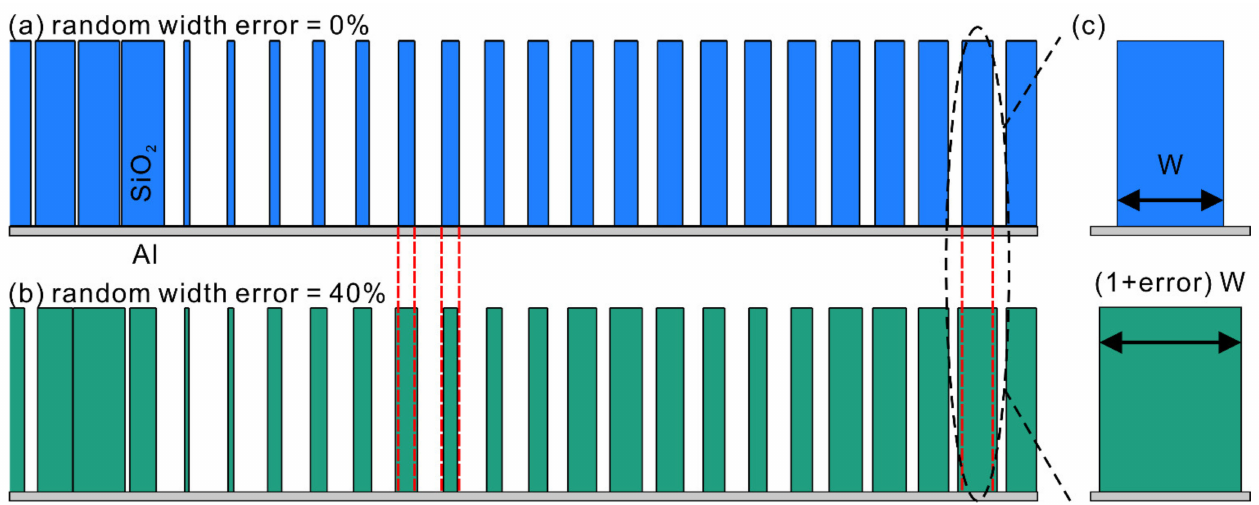
Figure A5. Schematic illustration of two metasurfaces with ( a ) 0% and ( b ) 40% random width error. ( c ) An enlarged view to show the different width of SiO 2 stripes that correspond to W and (1 + error ) W,